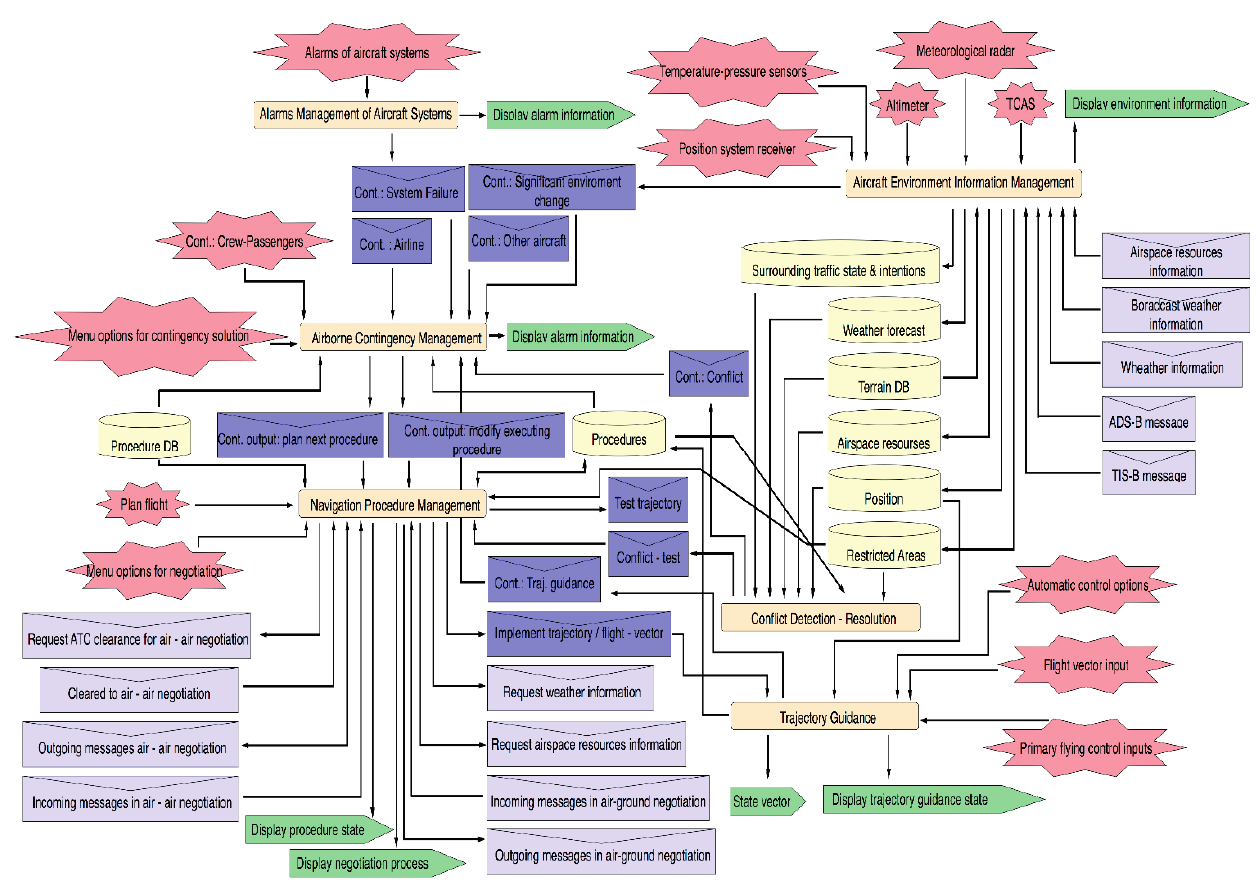
Figure 7. Aircraft Agent